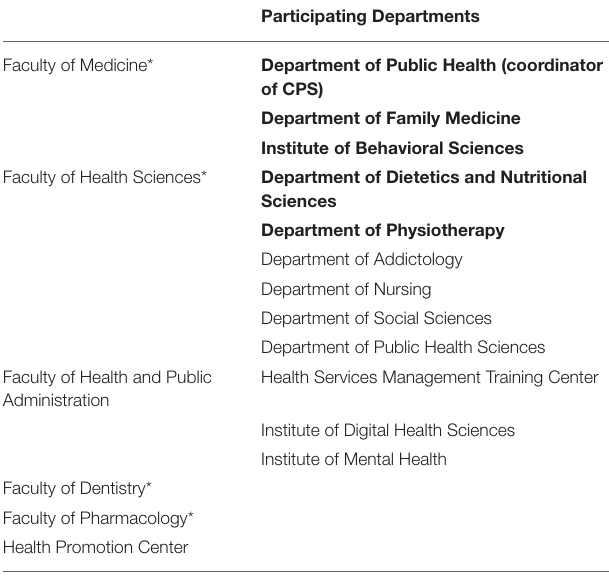
TABLE 1 | Faculties and departments of the Semmelweis University participating in the Caring University Model